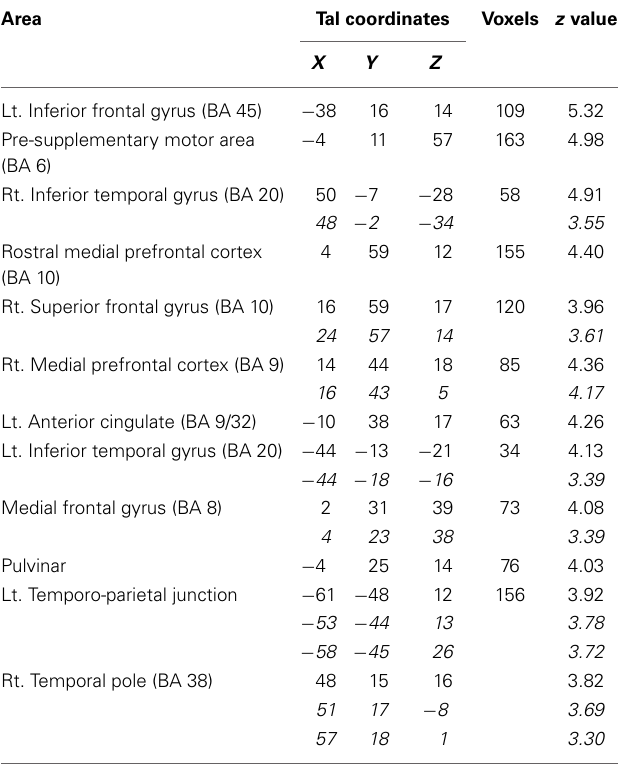
Table 2 | Areas activated in the contrast interpersonal emotion regulation (reappraisal and suppression combined) > watch.